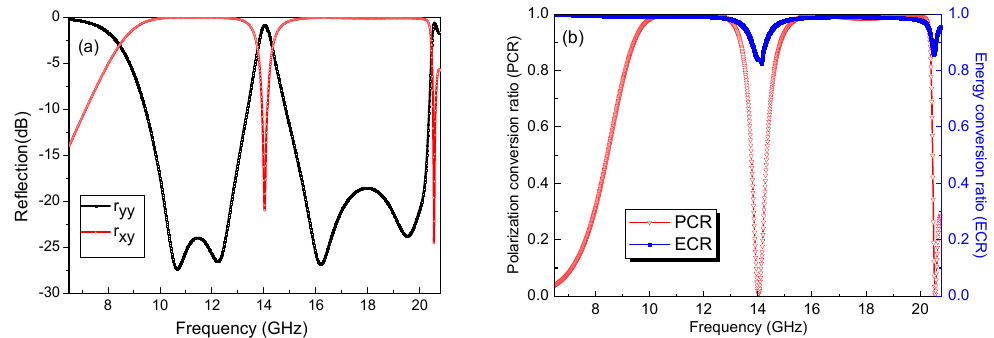
Figure 2. ( a ) Simulated cross-polarization ( r xy ) and co-polarization ( r yy ) reflections of the designed polarization converter. ( b ) Spectra of the polarization conversion ratio (PCR) and energy conversion ratio (ECR).